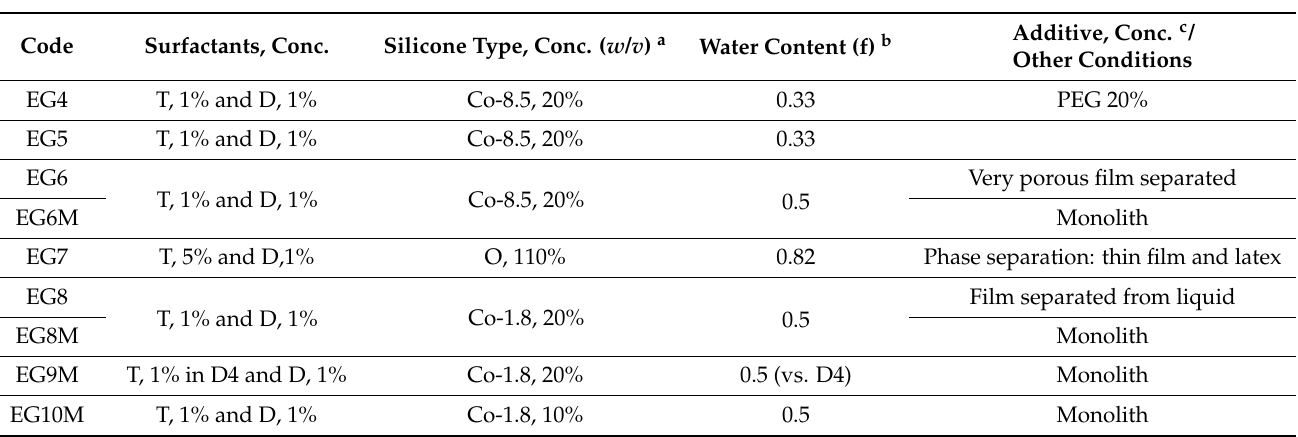
Table 1. Components of the emulsion